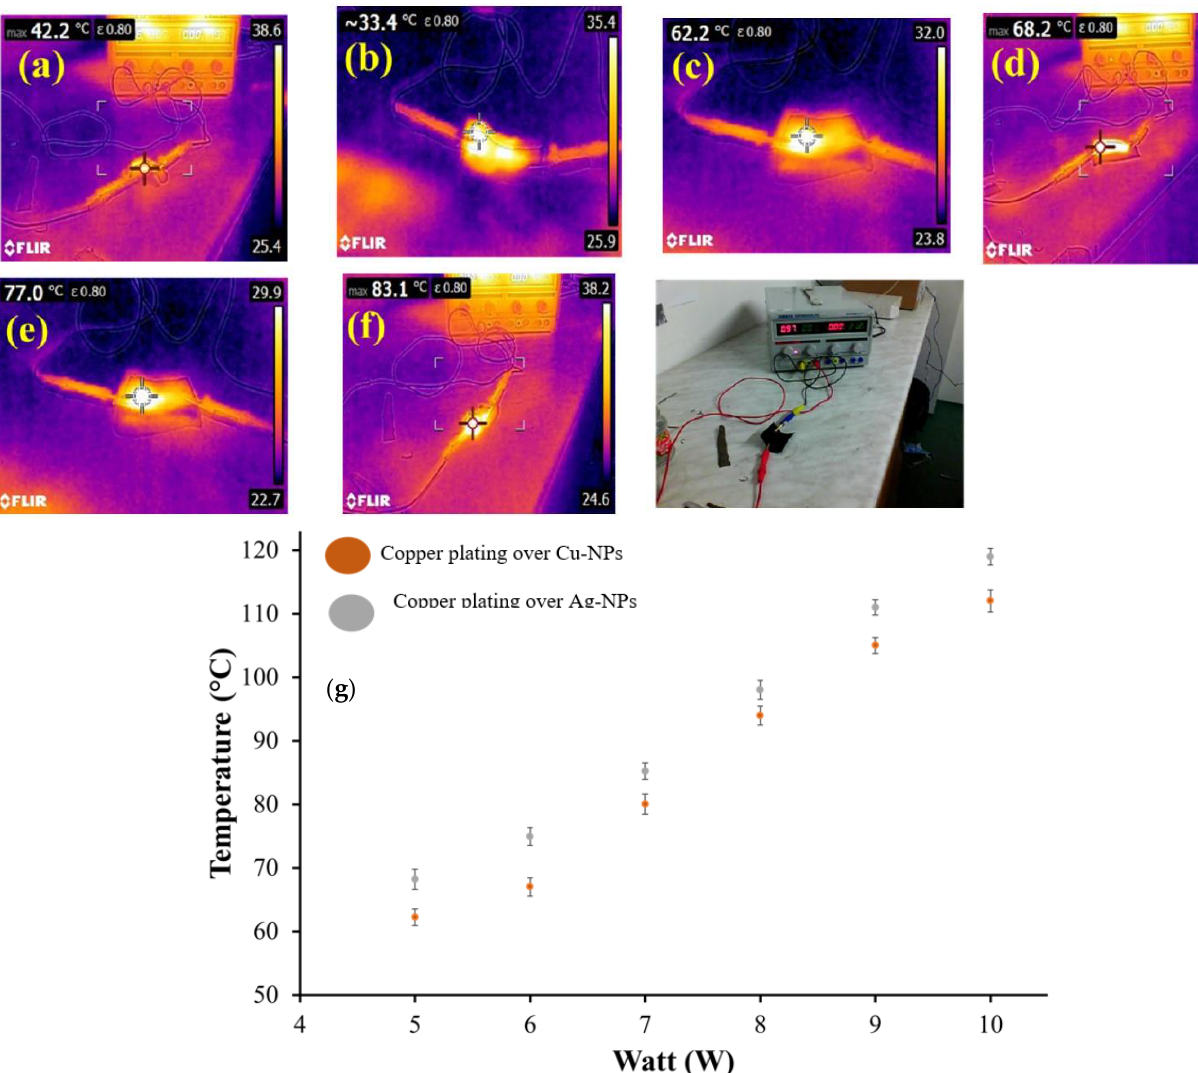
Figure 16. Surface temperature of copper plated fabrics samples: step one at 5 V and 1 min for ( a ) Cu-NPs coated fabric, ( b ) Ag-NPs coated fabric ( c ) electro-plated copper for Cu-NPs coated woven cotton fabric, ( d ) electro-plated copper for Ag-NPs coated woven cotton fabric respectively, step two at 5 volt and 10 min ( e ), ( f ) and step three at 5–10 watt ( g ).